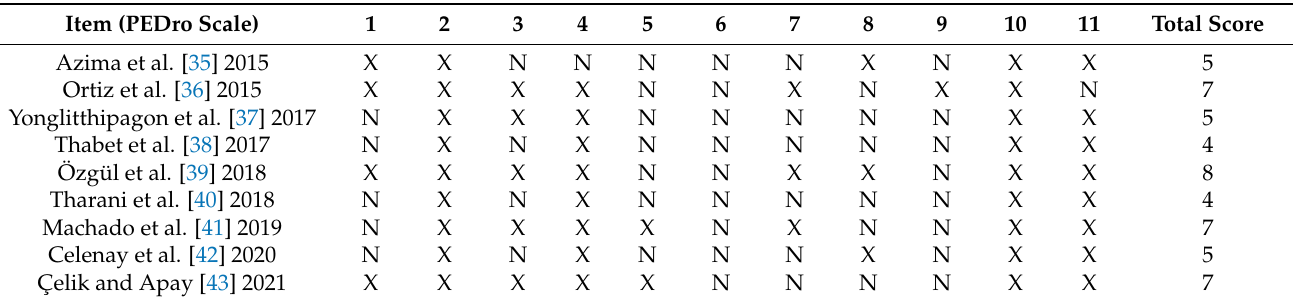
Table 4. Summary of the quality of the randomized clinical trials included in this review based on the PEDro scale.